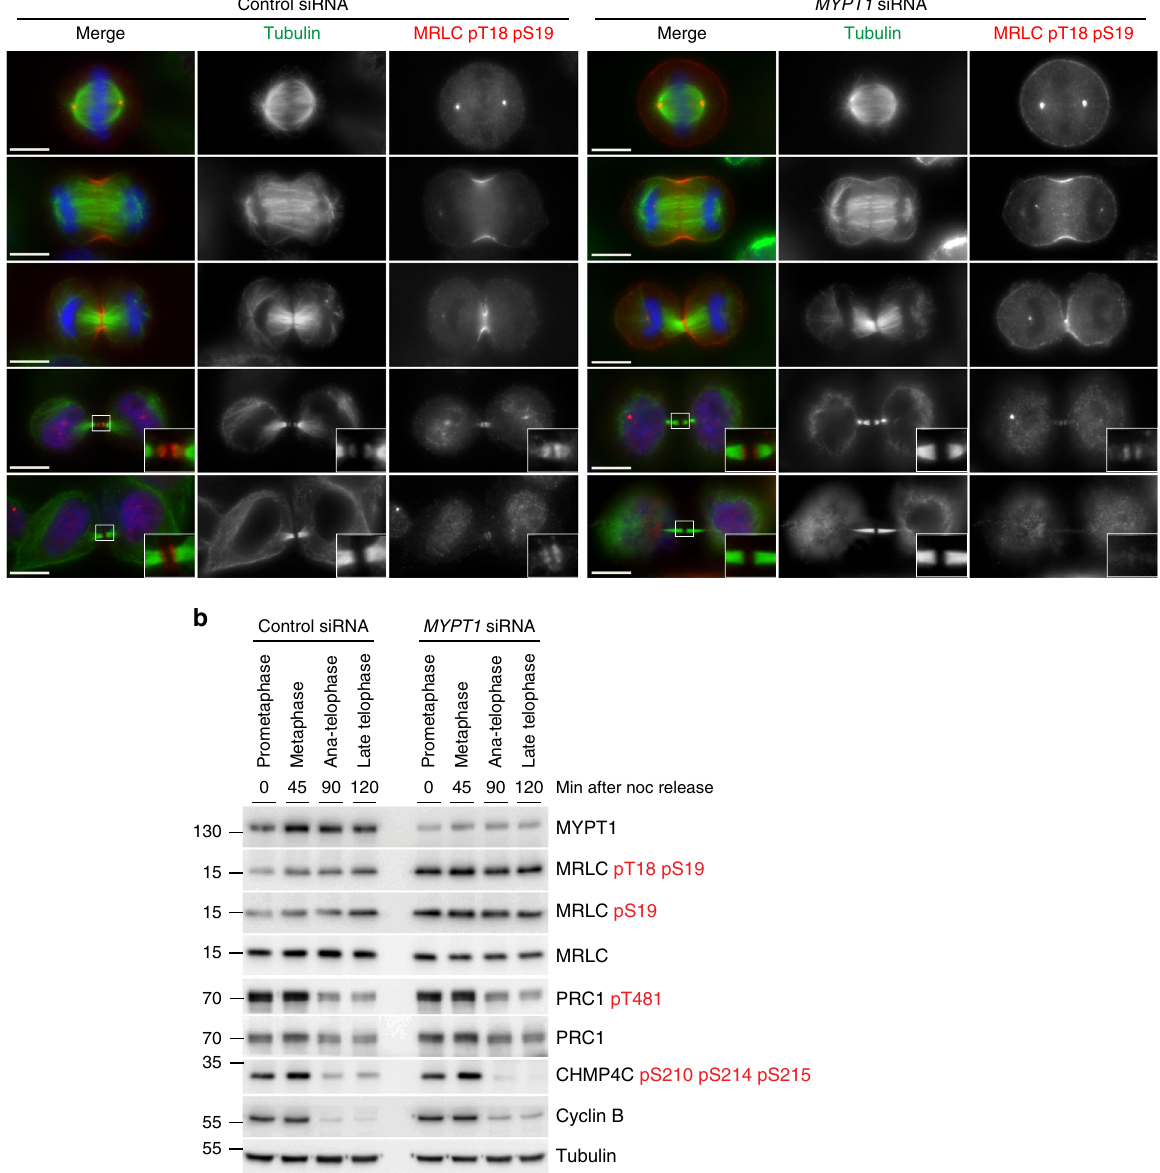
Fig. 5 MYPT1 siRNA increases the levels of phosphorylated MRLC, but does not impair furrowing and dephosphorylation during mitotic exit. a HeLa cells were treated with siRNAs directed against either a random sequence (control) or MYPT1 and after 48 h were fi xed and stained to detect DNA (blue in the merged panels), tubulin, and di-phosphorylated MRLC pT18 pS19. DNA condensation and the shape and thickness of microtubule bundles at the intercellular bridge were used as criteria to stage telophase cells. Insets show a 3× magni fi cation of the midbody. Scale bars, 10 µ m. b Time course analysis of protein expression and phosphorylation during mitotic exit after MYPT1 depletion. HeLa cells were treated with siRNAs directed against either a random sequence (control) or MYPT1 and after 24 h synchronized by thymidine/nocodazole block. Cells were collected at the indicate time points after nocodazole (noc) release and proteins extracted and used in western blot analysis to identify the proteins and phospho-epitopes indicated to the right. The numbers on the left indicate the sizes of the molecular mass marker. Source data for Fig. 5b are provided as a Source Data fi